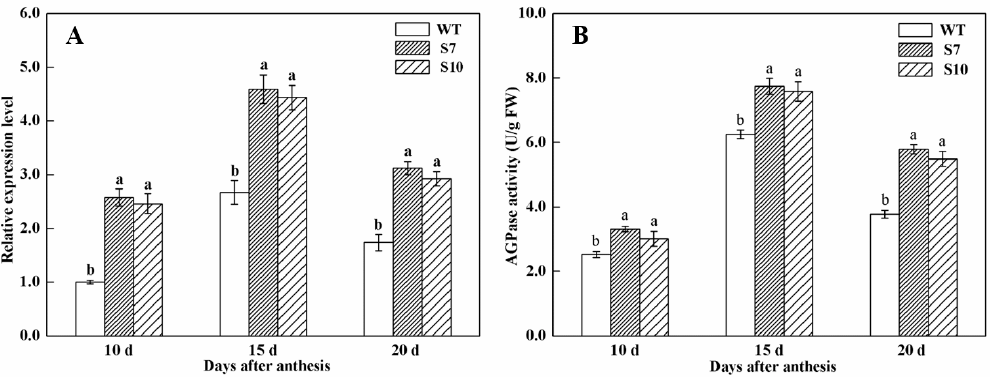
Figure 3. Transcript levels of TaAGPS1b-EU586278 ( A ) and AGPase activities ( B ) in endosperm of the developing grains of WT and transgenic wheat lines. Notes: (1) Transcript levels at 10, 15 and 20 days after anthesis were measured by qPCR using β -actin gene as internal control. (2) WT, the untransformed wild plant; S7 and S10, the two independent TaAGPS1b-EU586278 T 3 transgenic wheat lines. (3) Each value is the mean ± SD of three independent biological replicates. Different letters represented statistical significance at p <